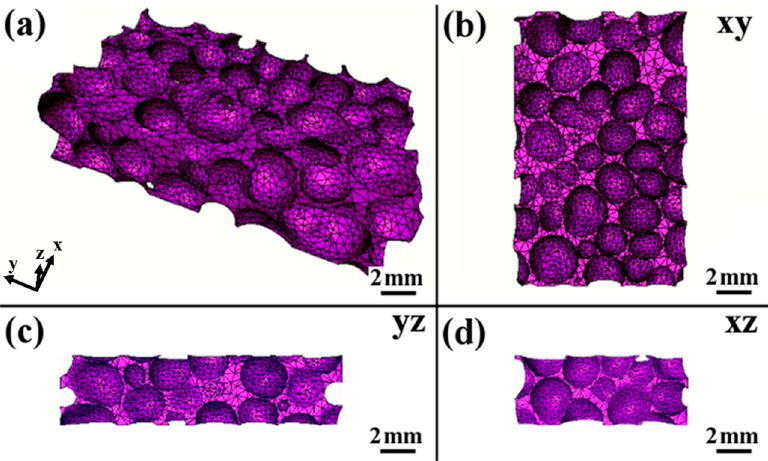
Figure 1. Compatible 3D finite-element meshes obtained by using the Amira software: ( a ) the whole mesh was shown in 3D dimensional diagram; ( b – d ) the cross-sectional diagrams from three mutually perpendicular planes.